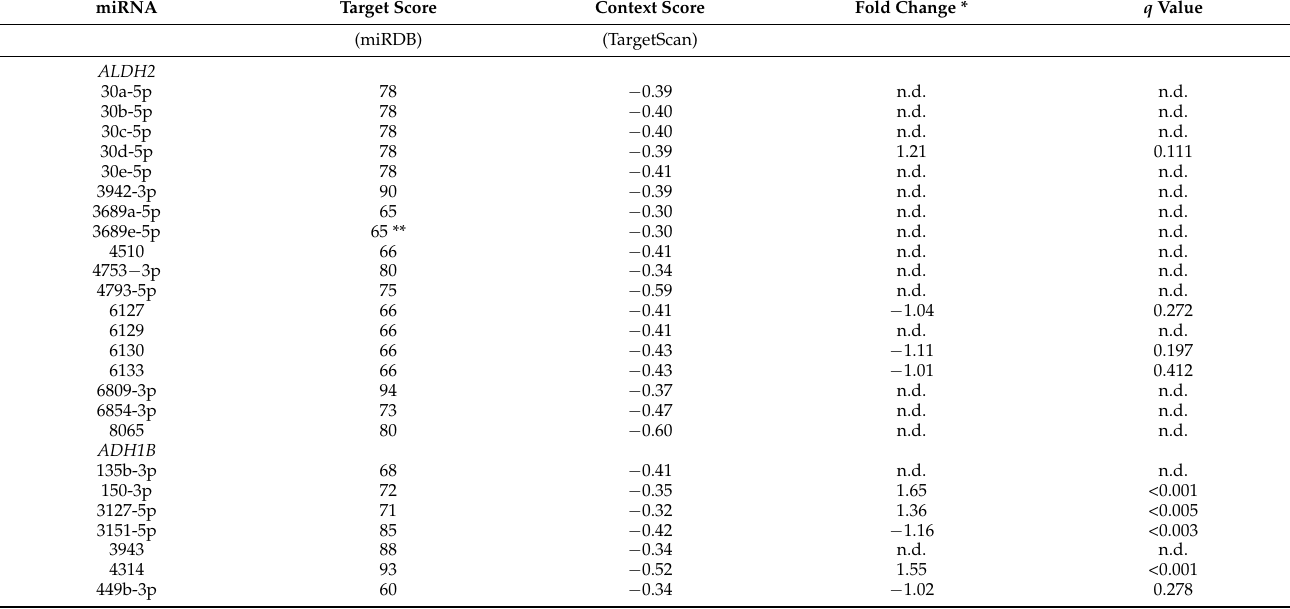
Table 2. Comparison of ALDH2- and ADH1B-related miRNA levels in serum of Austrian and Japanese men.